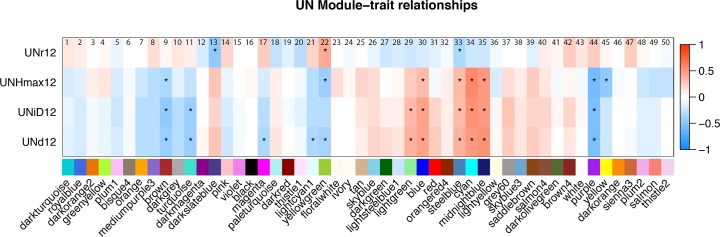
Correlations among WGCNA identified eigengenes and UN 2012 FVT traits.Significant correlations are denoted with an asterisk. r, growth rate; d, duration of growth; iD, time in degree days when the growth curve reached its inflection point; Hmax, estimated maximum height based on FVT modeling. Modules are named using a numerical system (above) and color scheme (below).